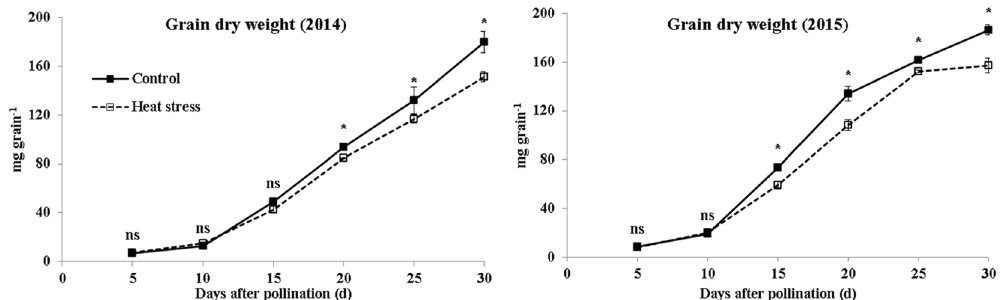
Figure 2. Grain dry weight during grain filling under ambient and high-temperature conditions. Bars denote standard errors from three replicates, and one-way ANOVA was used to test for significance at p < 0.05